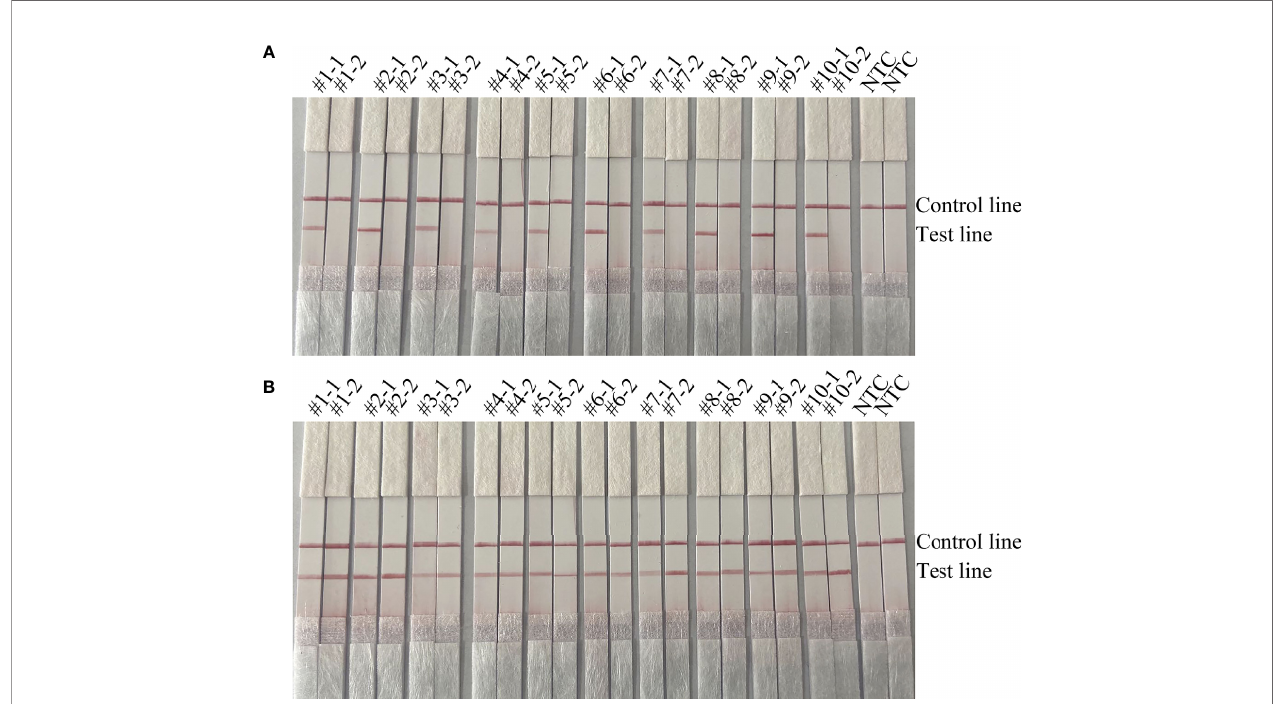
FIGURE 2 | Validation of the speci fi city of the primer pairs omp6 -F3/R1B/P and bexA -F3/R1B/P for capsulated and non-capsulated H. in fl uenzae . -1 refers to the test results of omp6 -F1/R1, − 2 refers to the test results of bexA -F2/R2: (A) #1 – #10 refer to the ten non-capsulated H. in fl uenzae isolated from sputum; (B) #1 – #10 refer to the ten capsulated H. in fl uenzae isolates from sputum. NTC, no template control. The positions of the test and control lines are marked on the right of the strip